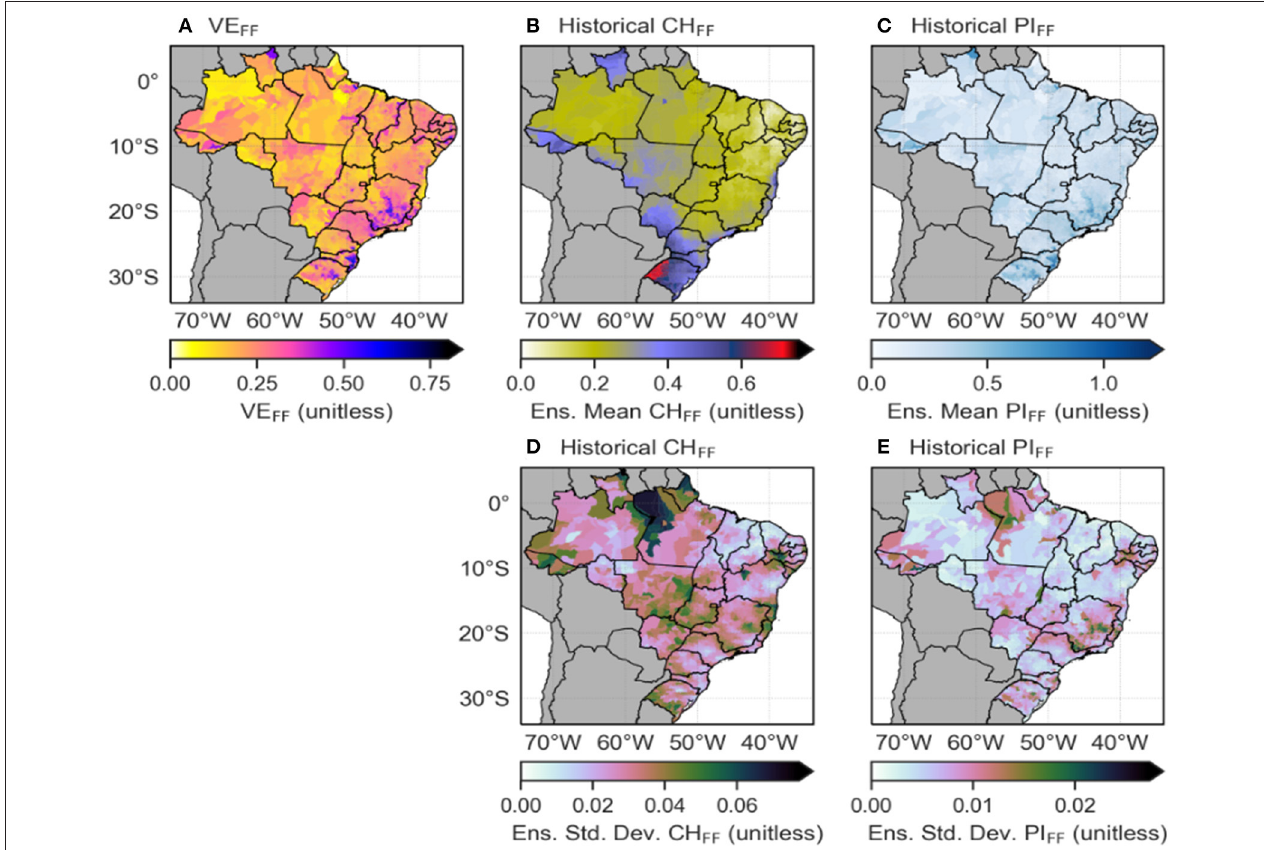
FIGURE 4 | Geographical distribution of (A) the vulnerability-exposure index for flash floods (VE FF ), (B,D) the ensemble mean and standard deviation of the historical climatic hazards index for flash floods (CH FF ), respectively, as well as (C,E) the ensemble mean and standard deviation of the historical potential impact index for flash floods (PI FF